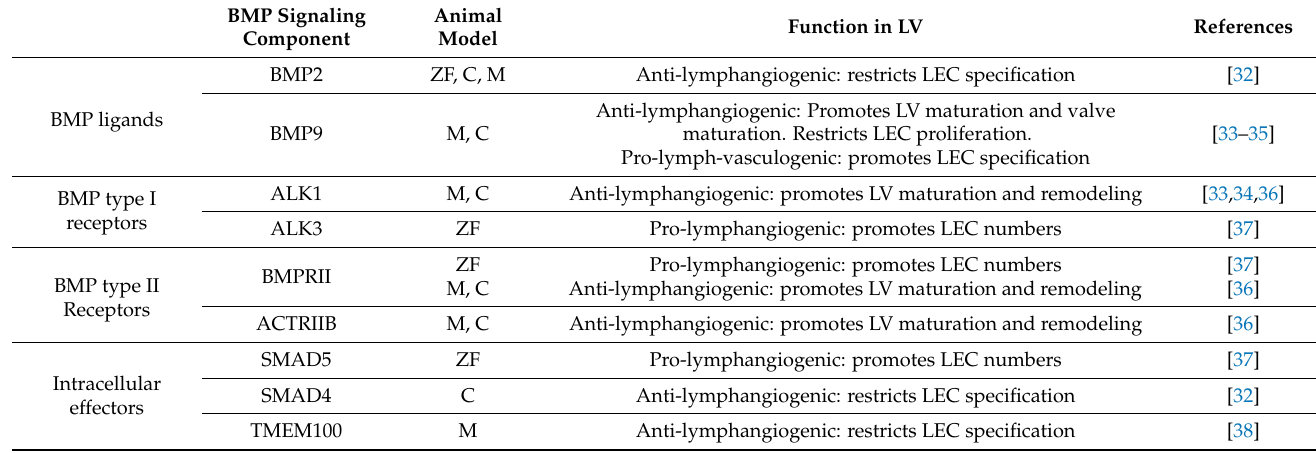
Table 1. Overview of BMP signaling components that function in lymphatic vessel (LV) biology in mouse (M) and zebrafish (ZF) models or lymphatic endothelial cell (LEC) culture experiments (C). BMP Signaling